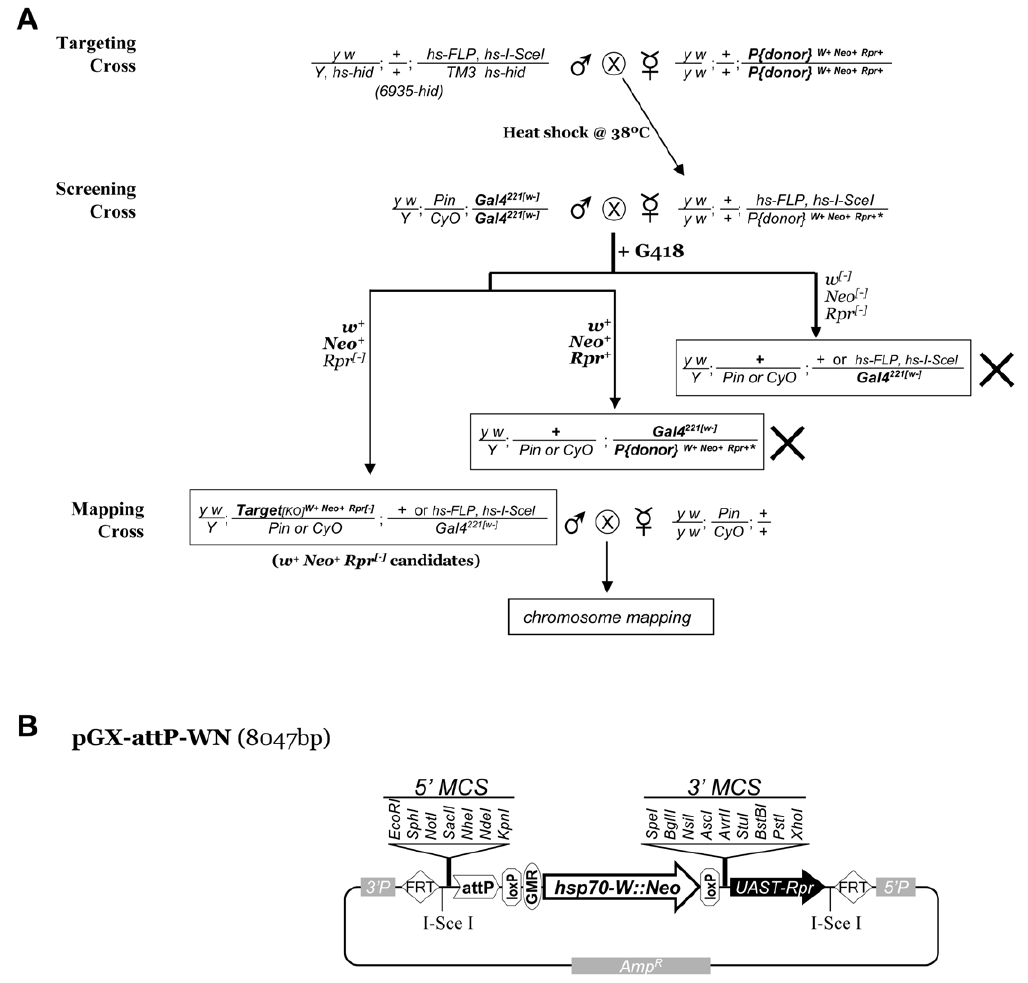
Figure 1. Application of multiple selections in gene targeting. A . Genetic crosses of ends-out targeting based on the dual positive screening of w + and Neo + for targeting candidates, together with the negative selection of UAS-Rpr (Rpr + ) for eliminating false positives. ‘‘X’’: genotypes eliminated or greatly reduced in numbers by G418 selection or UAS-Rpr counter-selection. B . Map of pGX-attP-WN. pGX-attP-WN is a P-element based transforming vector. 5 9 P and 3 9 P : 5 9 and 3 9 P-element sequences; Amp R : ampicillin-resistant gene.